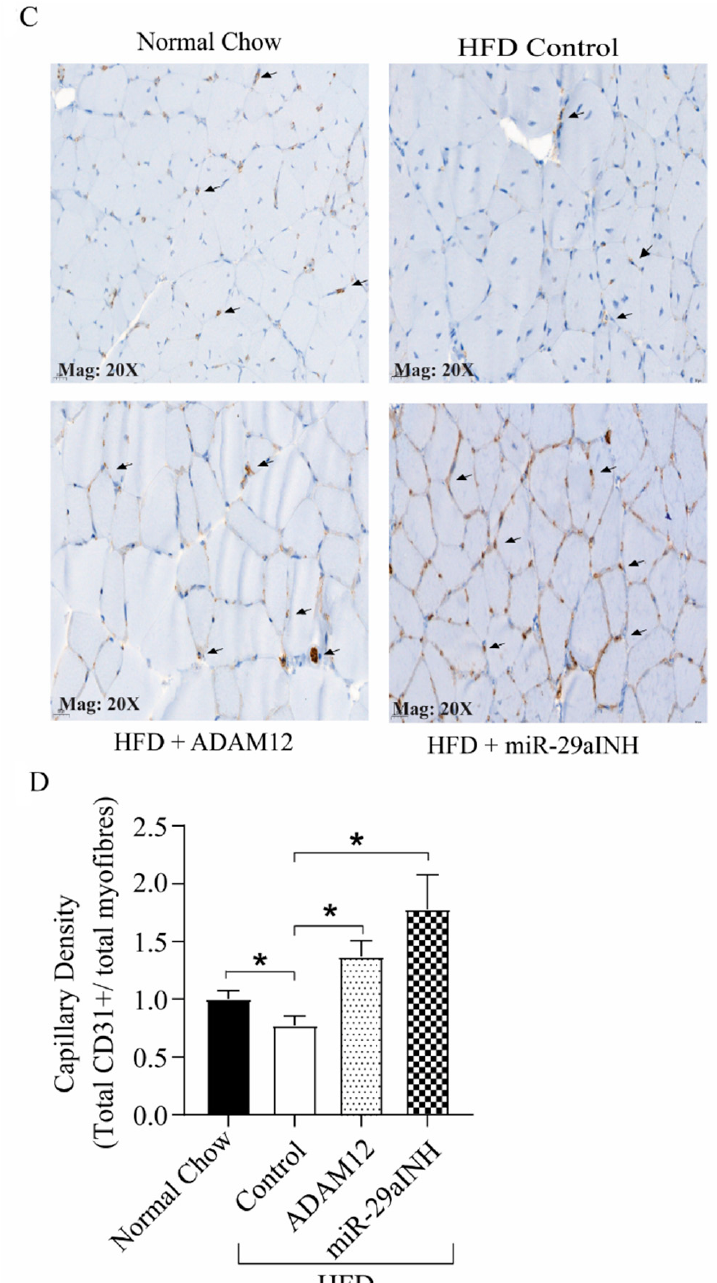
Figure 3. ADAM12 gene transfer and inhibition of miR-29a improved perfusion recovery and capillary density in HFD mice. ( A ): Representative laser speckle contrast imaging (LSCI) showing increased perfusion in post-ischemic limb of HFD mice treated with ADAM12 gene transfer or miR- 29a inhibitor. ( B ): Quantification of perfusion recovery post HLI. y -Axis shows extent of perfusion in the ischemic limb relative to the non-ischemic limb; x -axis shows days following experimental PAD (day-21 percent perfusion recovery * p < 0.05, ** p < 0.01 and Normal Chow: n = 6, HFD Control: n = 6, HFD + ADAM12: n = 7 and HFD + miR29aINH: n = 8). ( C ): GA muscle sections from day 21 post-ischemic GA muscle from normal-chow-fed mice, HFD mice, HFD + ADAM12 and HFD + miR-29a inhibitor treated animals were subjected to immunohistostaining for CD31 to identify capillaries. Representative images of stained sections are shown (scale bar = 20 × ). ( D ). Quantification of CD31 + cells per muscle fiber (* p < 0.05 and Normal Chow: n = 4, HFD Control: n = 4, HFD + ADAM12: n = 4 and HFD + miR29aINH: n = 4).